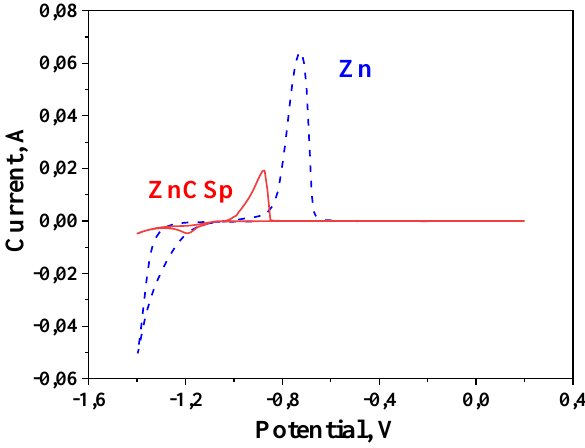
Figure 7. Cyclic voltammetry polarization (CVA) investigations of Zn and ZnCSp coatings.